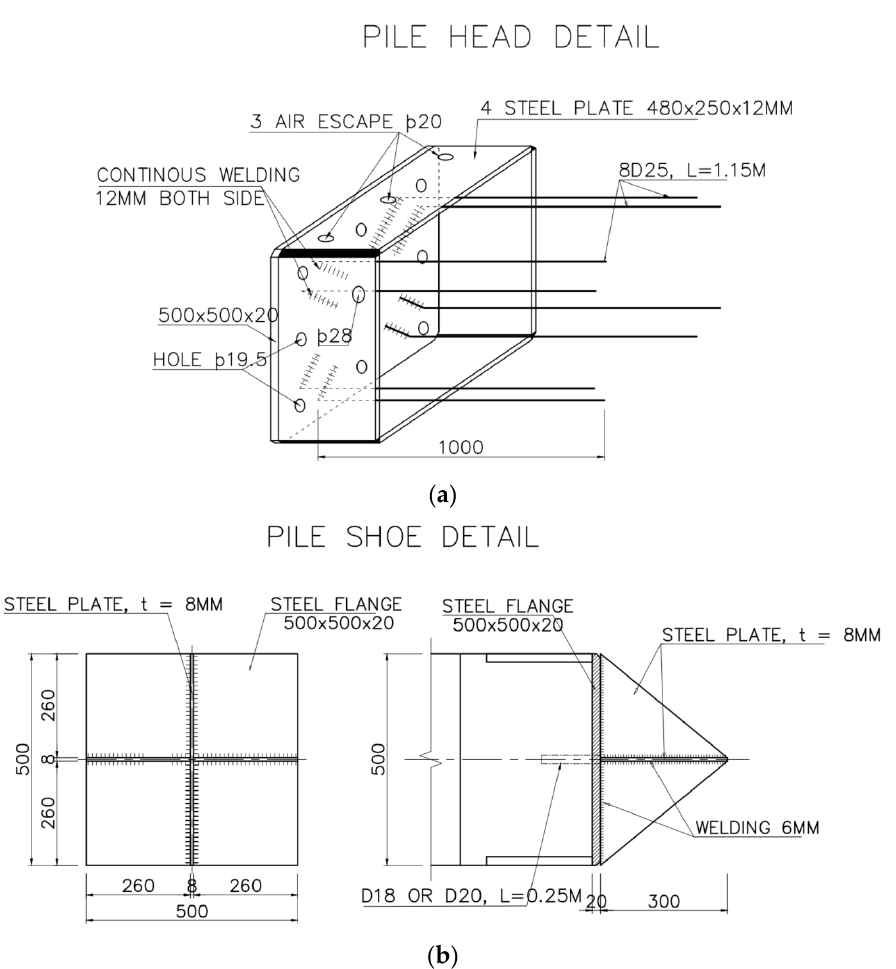
Table 3. Pile Tensile Strength.